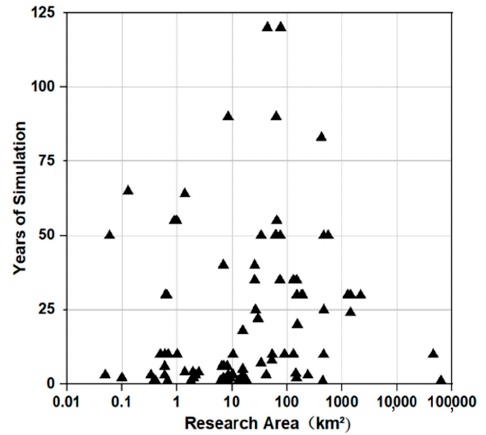
Figure 7. Spatio-temporal range of RHESSys-related research.